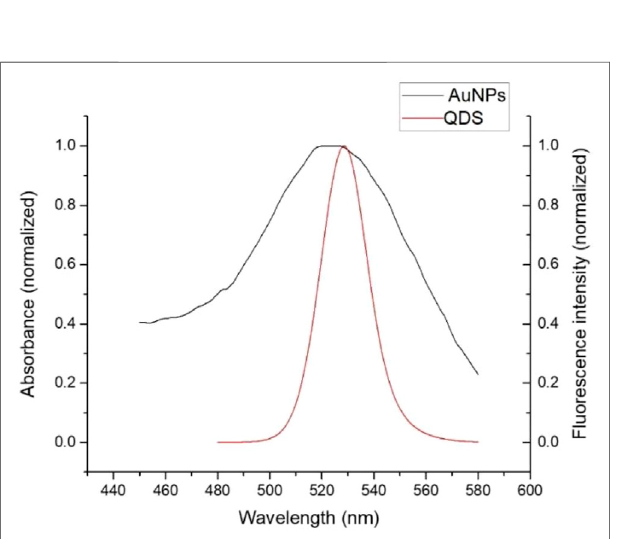
FIGURE 2| After normalization, the QDs ’ fl uorescence peak overlapped with the AuNPs ’ absorption peak.